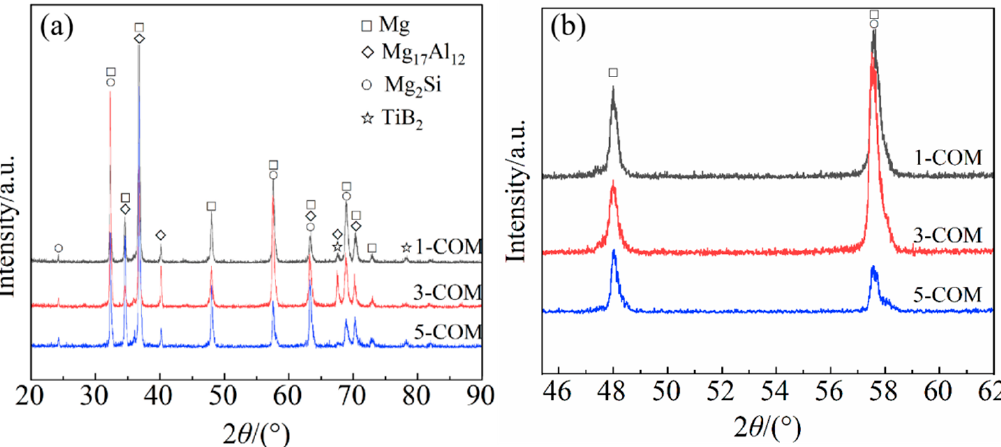
Figure 1. XRD patterns of TiB 2 /Mg-4Al-1.5Si composites: ( a ) 20° ≤ 2 θ ≤ 90° and ( b ) 46° ≤ 2 θ ≤ 62°.